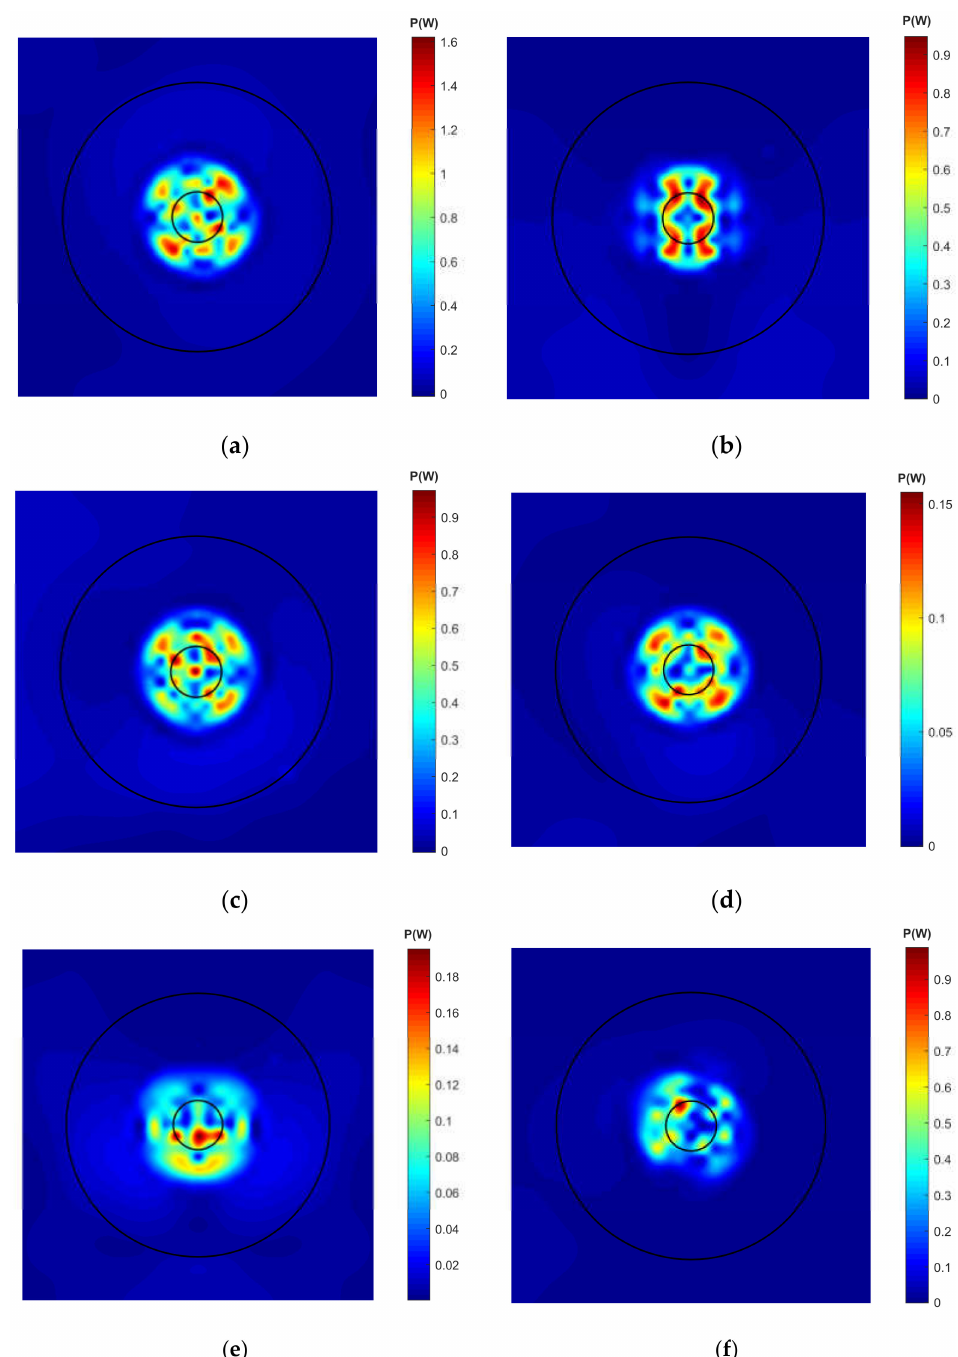
Figure A6. Structural intensity contours at an excitation frequency of 1100 Hz: ( a ) ABH(i) with BC 1, ( b ) ABH(ii) with BC 1, ( c ) ABH(iii) with BC 1, ( d ) ABH(i) with BC 2, ( e ) ABH(ii) with BC 2, ( f ) ABH(iii) with BC